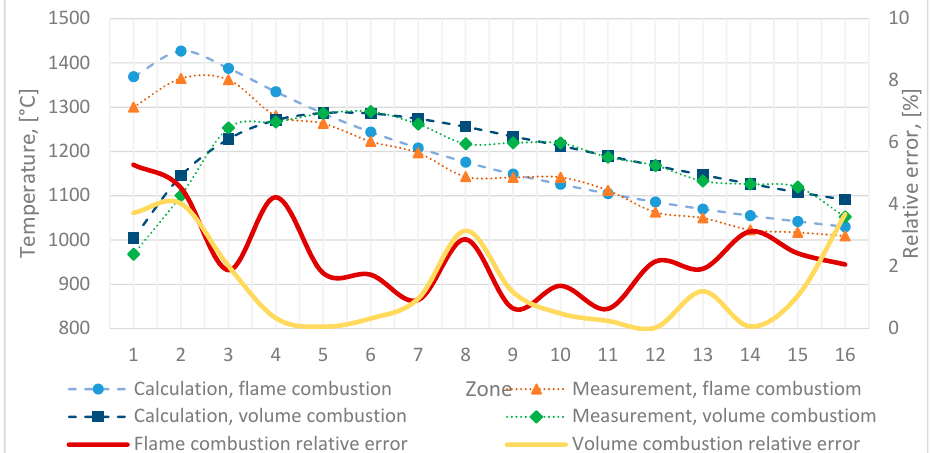
Figure 5. Results of the simulation and measurements.